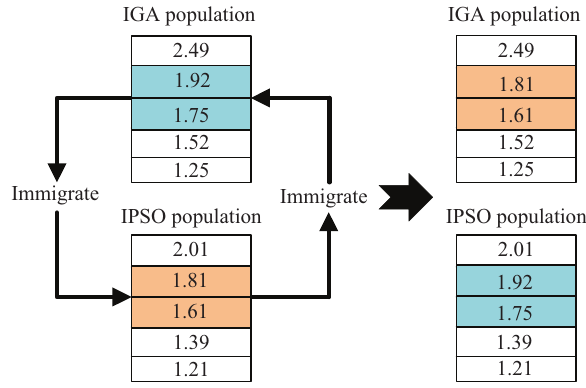
Figure 11. The immigrant process of two parallel branch populations.